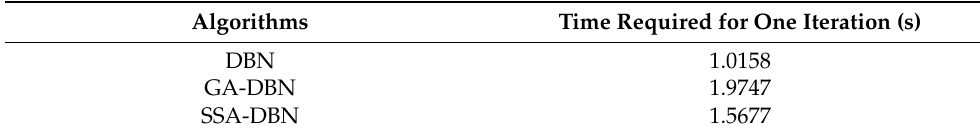
Figure 11. Comparison of the results of operation efficiency of the different algorithms. Table 8. Comparison of the efficiency of iterative operation of the different algorithms.